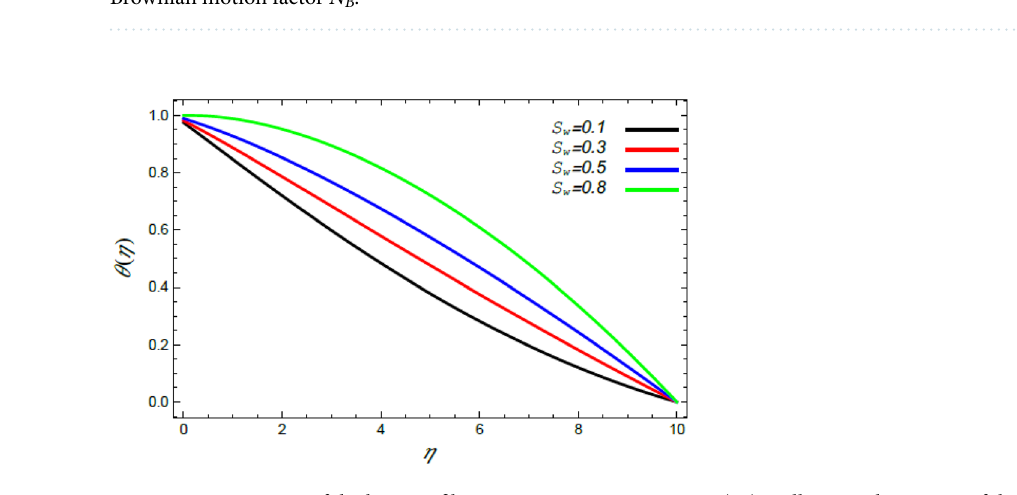
Figure 14. Deviation of the heat profile θ(η) versus η as given in Eq. (66) to illustrate the impact of the Stefan blowing factor S w